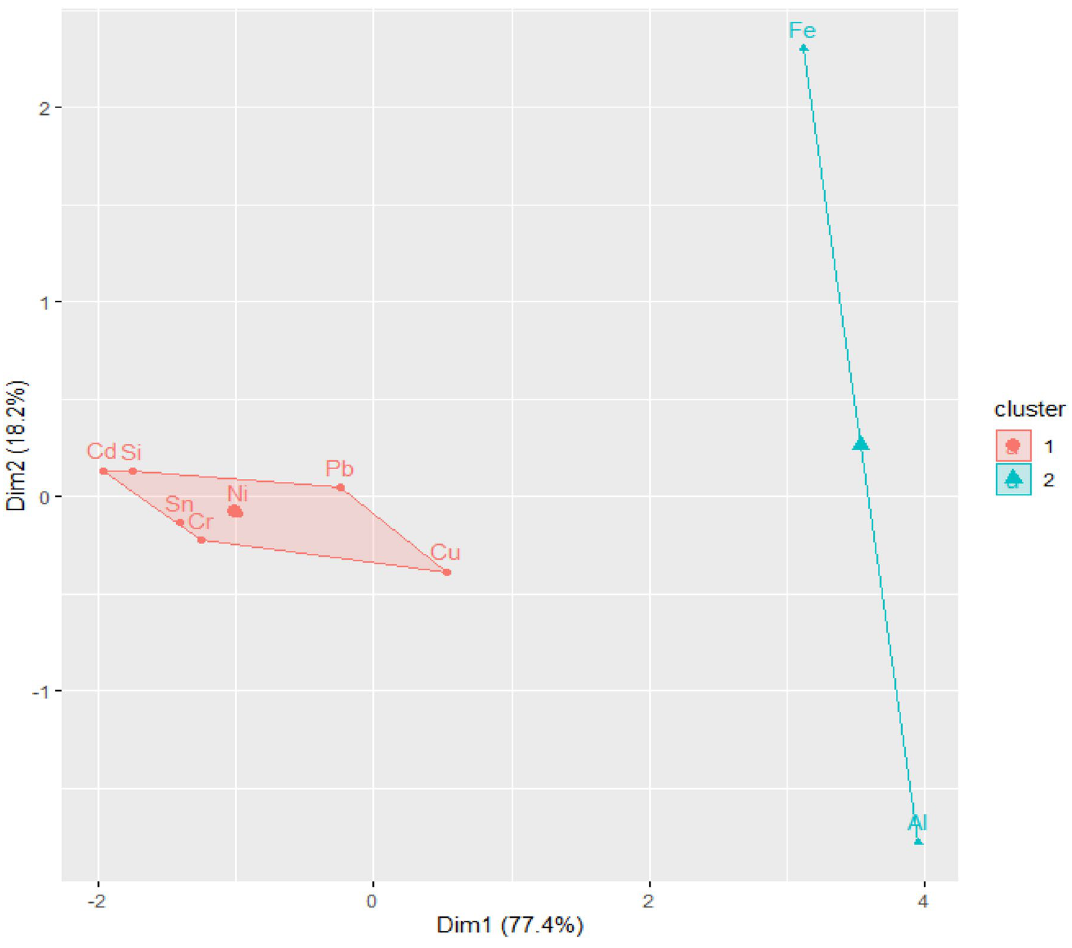
Fig. 8 Cluster analysis of heavy metals in Lagos lagoon water